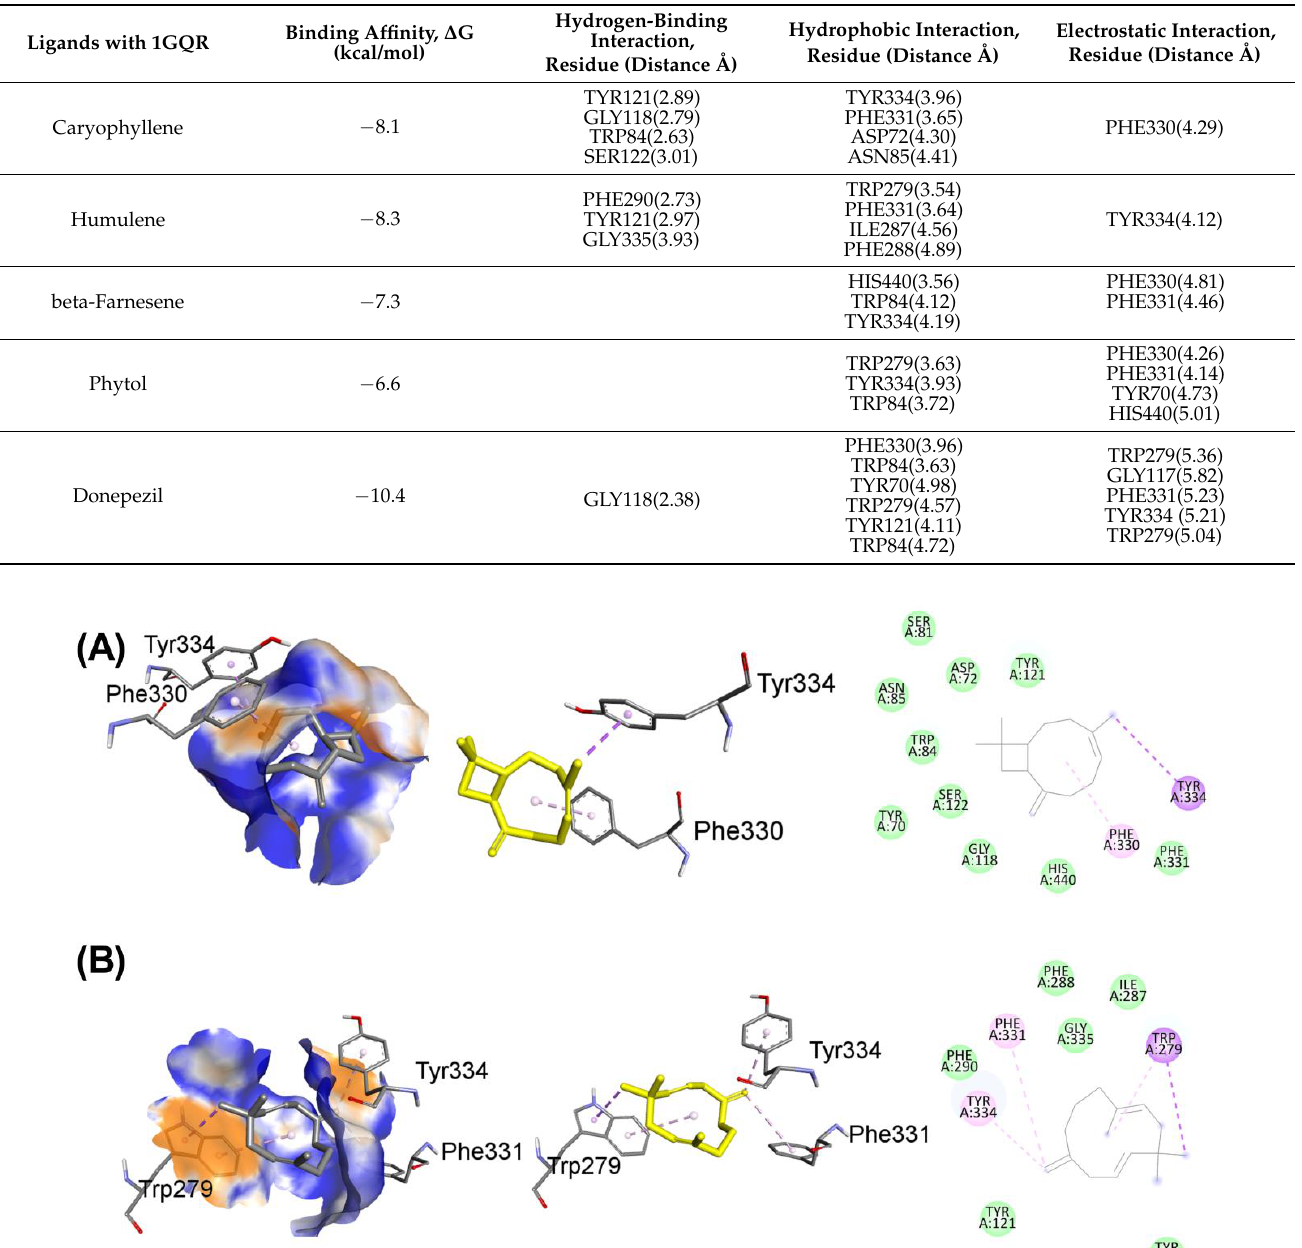
Table 2. Binding affinity (kcal/mol), hydrogen binding, and hydrophobic and electrostatic interac- tions with distances in Angstrom for investigated ligands using acetylcholinesterase protein having the PDB ID: 1GQR.